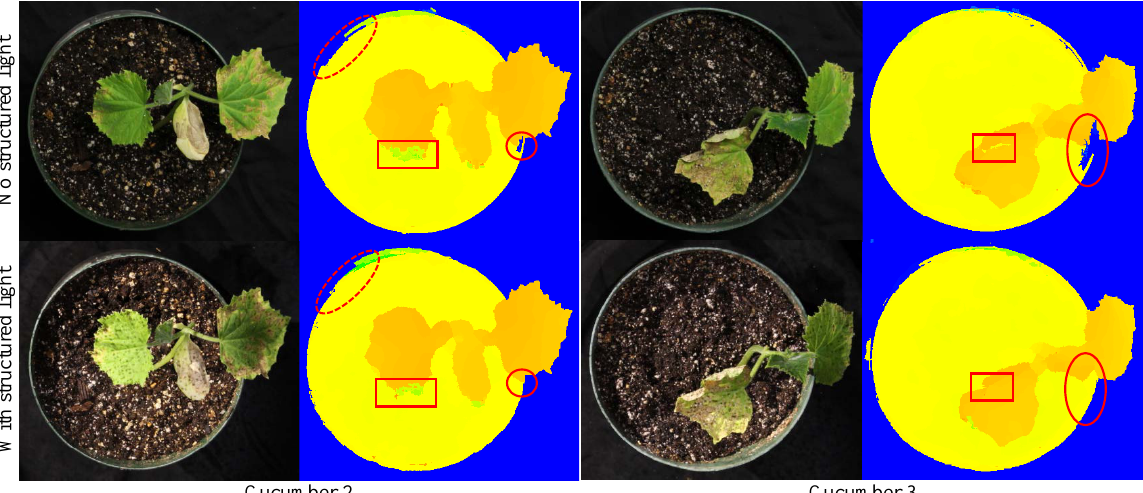
Figure 13. Comparison between without and with using structured light (SL) on textured leaves. The disparity result of using SL is slightly better than that without using SL in the regions of less natural textures (marked by red rectangles and ellipses). Note that the colorized disparity images are presented here, instead of grayscale ones, for better illustration of the